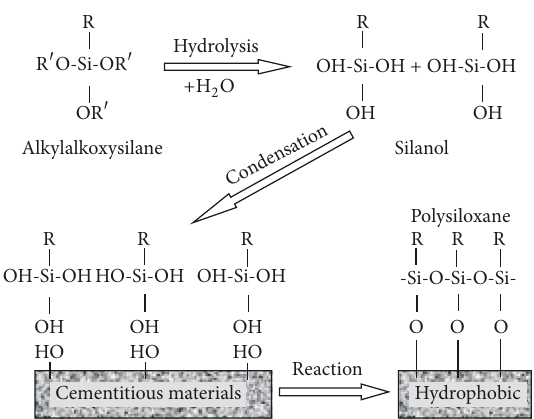
Figure 2: Mechanisms for hydrolysis and polymerization of silane in cement-based